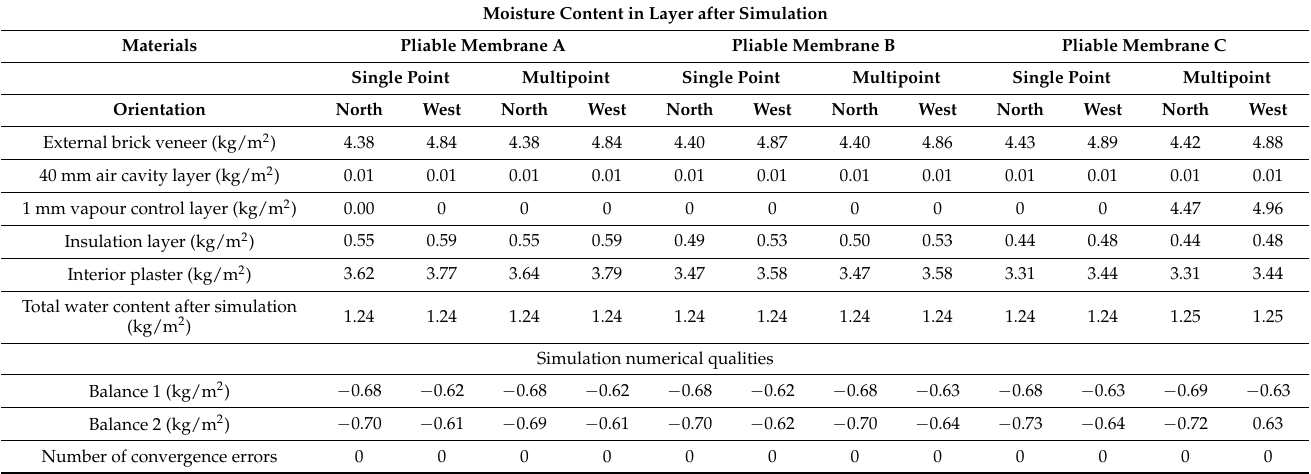
Table A1. Hygrothermal calculation result for Sydney climate on EPW climate file without rain data.